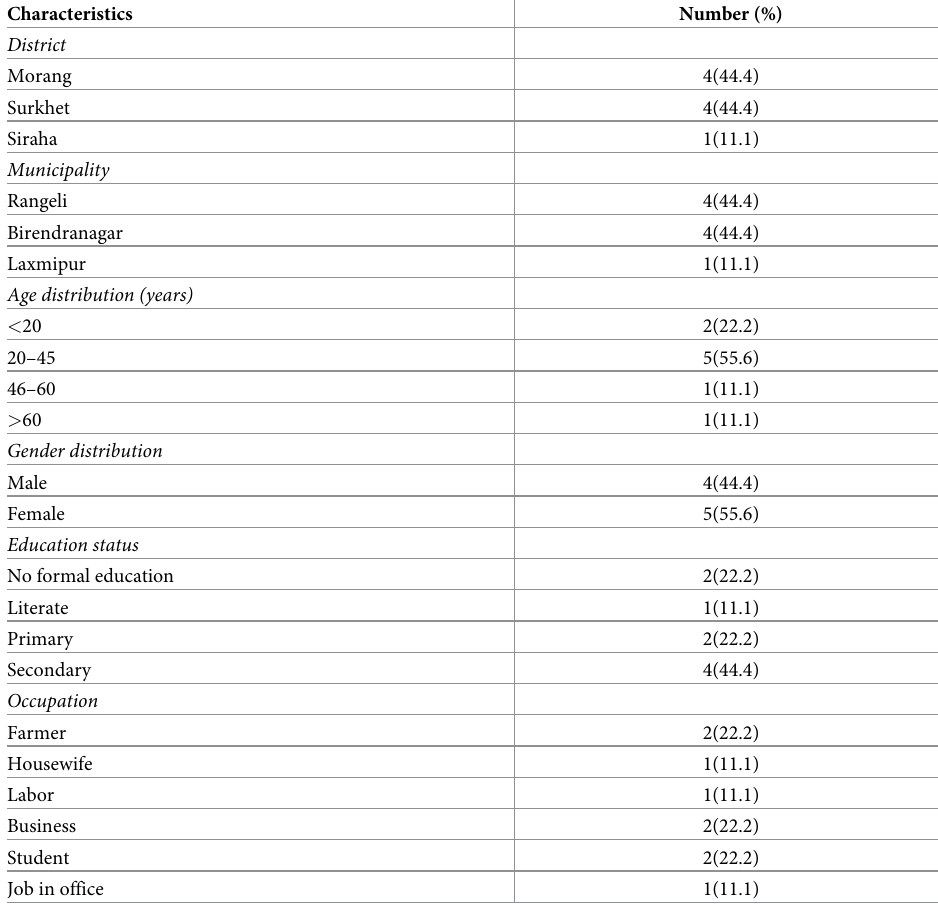
Table 4. Characteristics of 9 PKDL